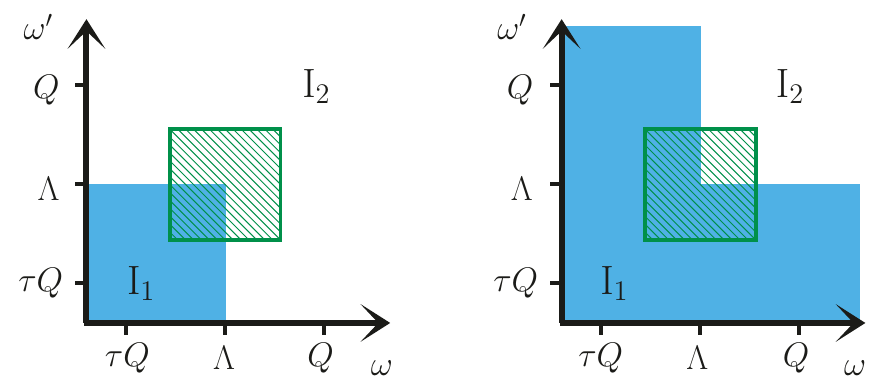
Figure 6 . Version (1) [left] and (2) [right] of the split of (4.16) into I 1 + I 2 according to the correspondingly indicated regions in the ω − ω 0 plane as described in the text below (4.16). In the overlap region in green the asymptotic behaviour of the A- and B-type term must